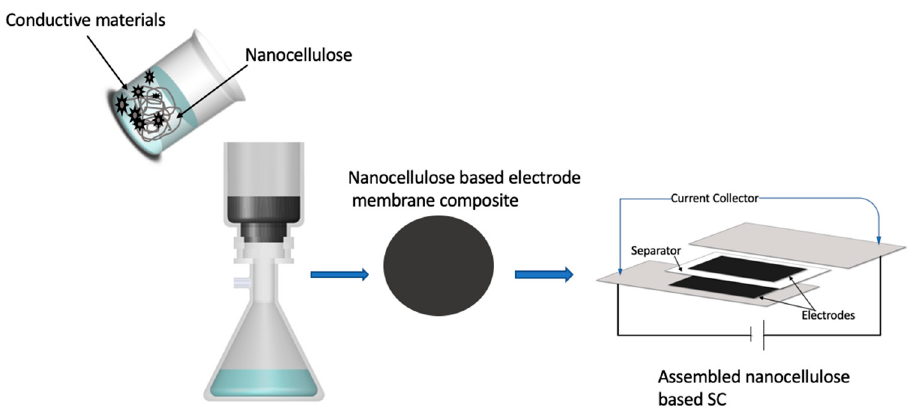
Figure 4. Filtration procedure to fabricate nanocellulose-based supercapacitor (SC).